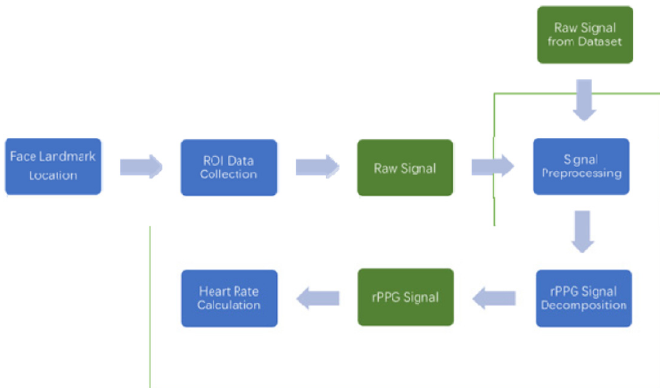
Figure 7. Evaluation of signal processing